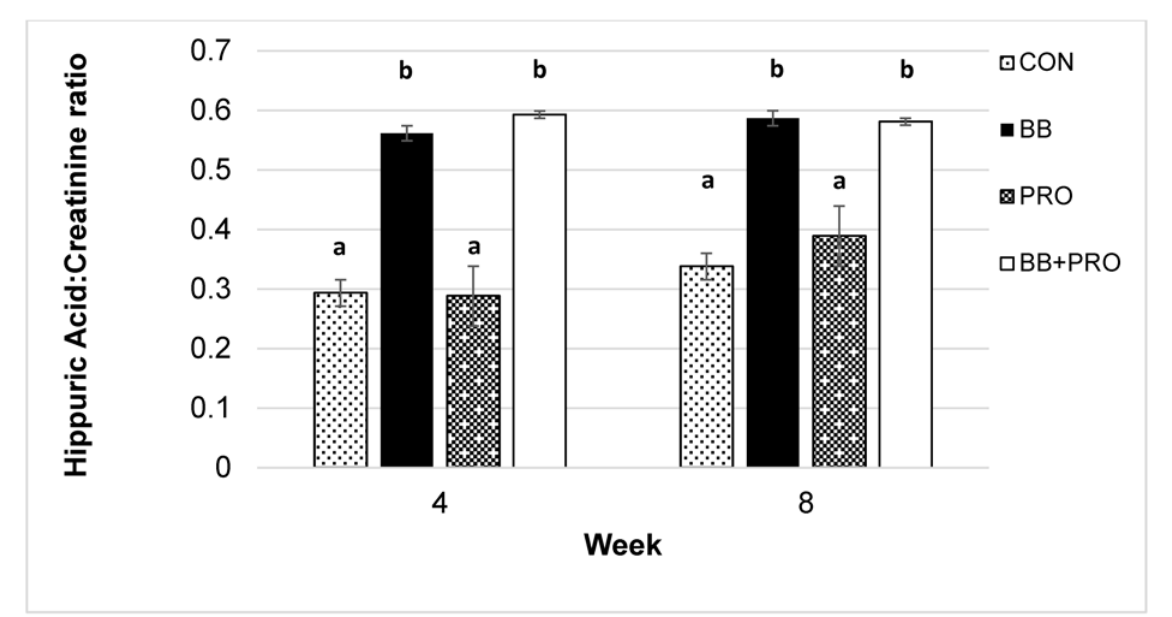
Fig 3. Urine levels of hippuric acid. Urine levels of hippuric acid normalized to creatinine at weeks 4 and 8 in spontaneously hypertensive rats fed control (CON), 3% blueberry (BB), 1% probiotic (PRO), or 3% blueberry + 1% probiotic (BB+PRO) diet for 8 weeks. Data points are presented as means ± SE bars for 8 rats in each diet group except CON week 8, where n = 7. Statistical analysis was performed using mixed models ANOVA with repeated measures and post-hoc comparisons with Tukey ’ s adjustment. Diet exerted a significant main effect on hippuric acid level, p < 0.0001. Within week, means with different letters are significantly different at p < 0.0001 except BB vs. PRO week 8 at p = 0.001 (S3